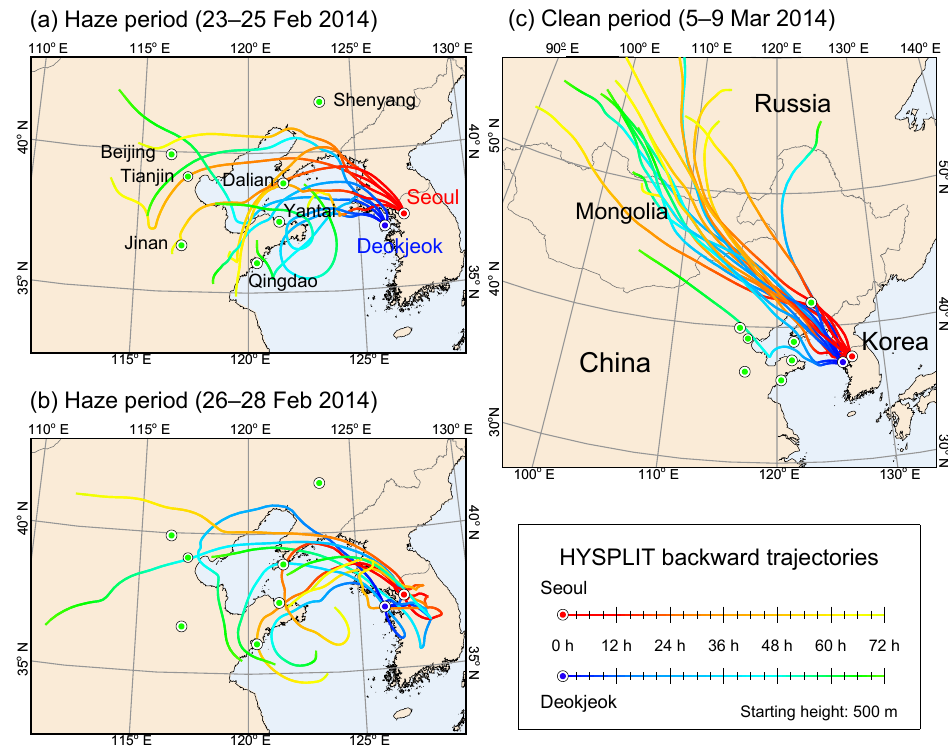
Figure 2. Backward trajectories from 500ma.s.l. over the KIST site in Seoul (red) and the Deokjeok site (blue) at 09:00 and 21:00 local time (GMT + 09:00) during (a) the early stage of haze, (b) the late stage of haze, and (c) the clean